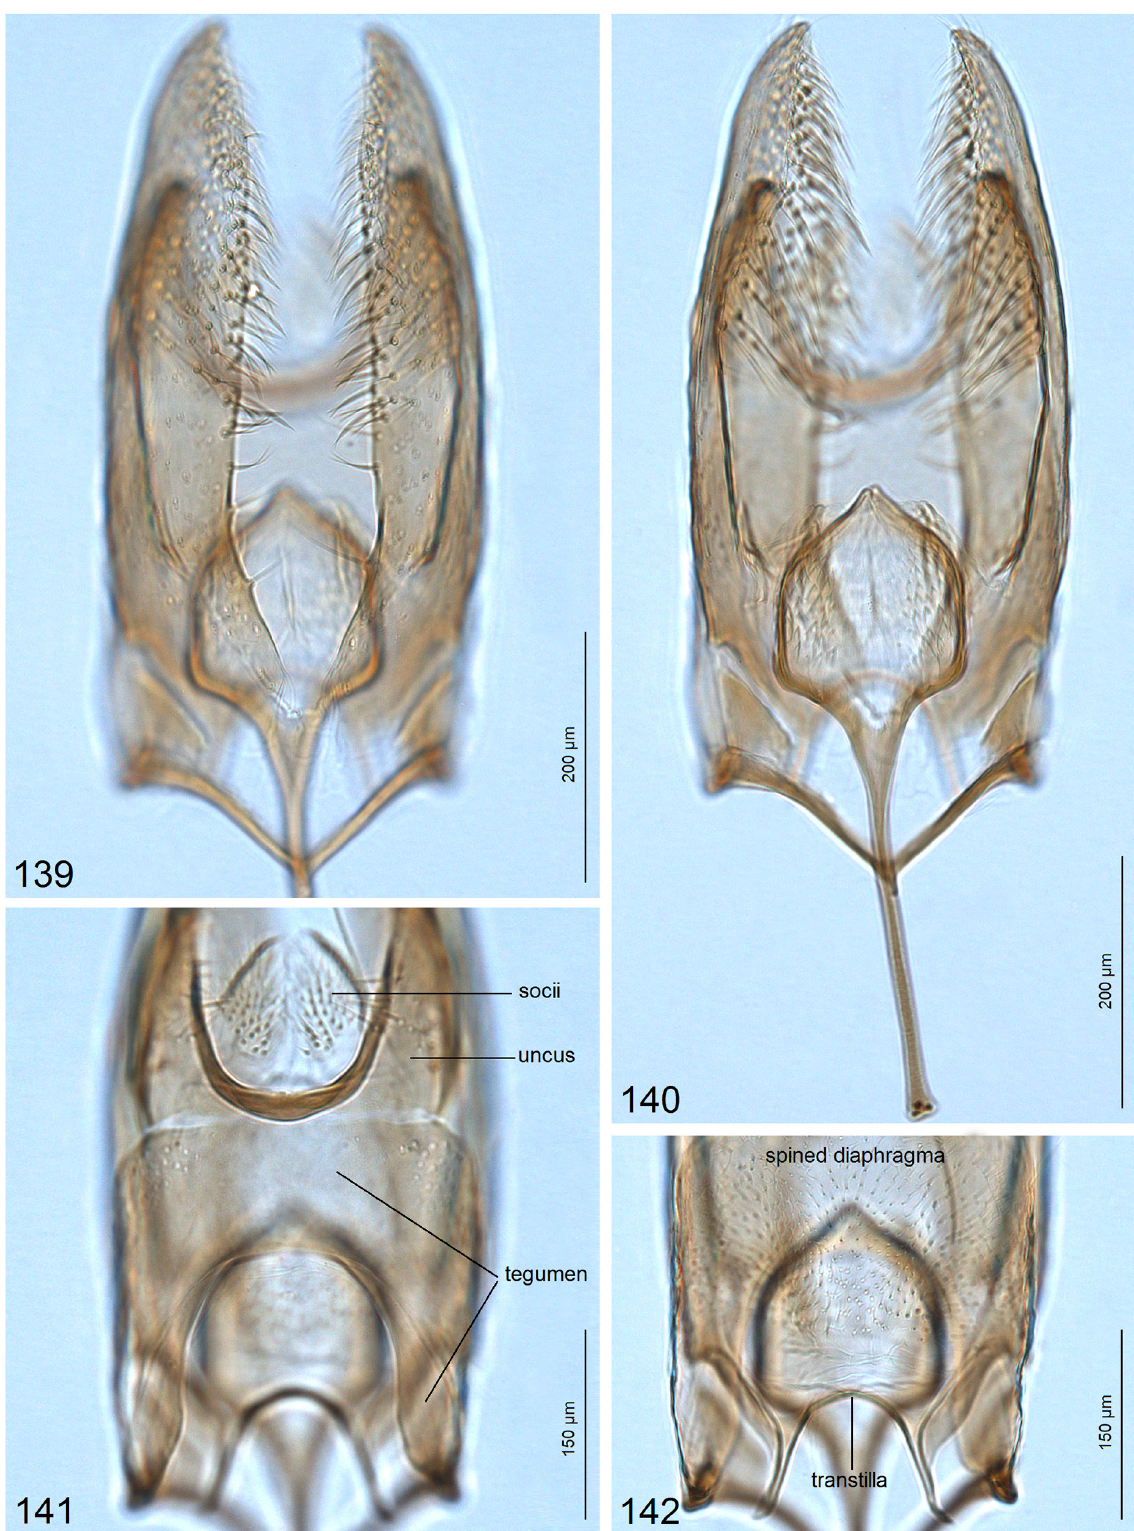
Figs 139–142. Male genitalia of Coptotriche forsteroniae Stonis & Diškus, 2008, paratype (genitalia slide no. 010316200, NHMUK). 139–140 . General view. 141 . Socii, uncus and tegumen. 142 .